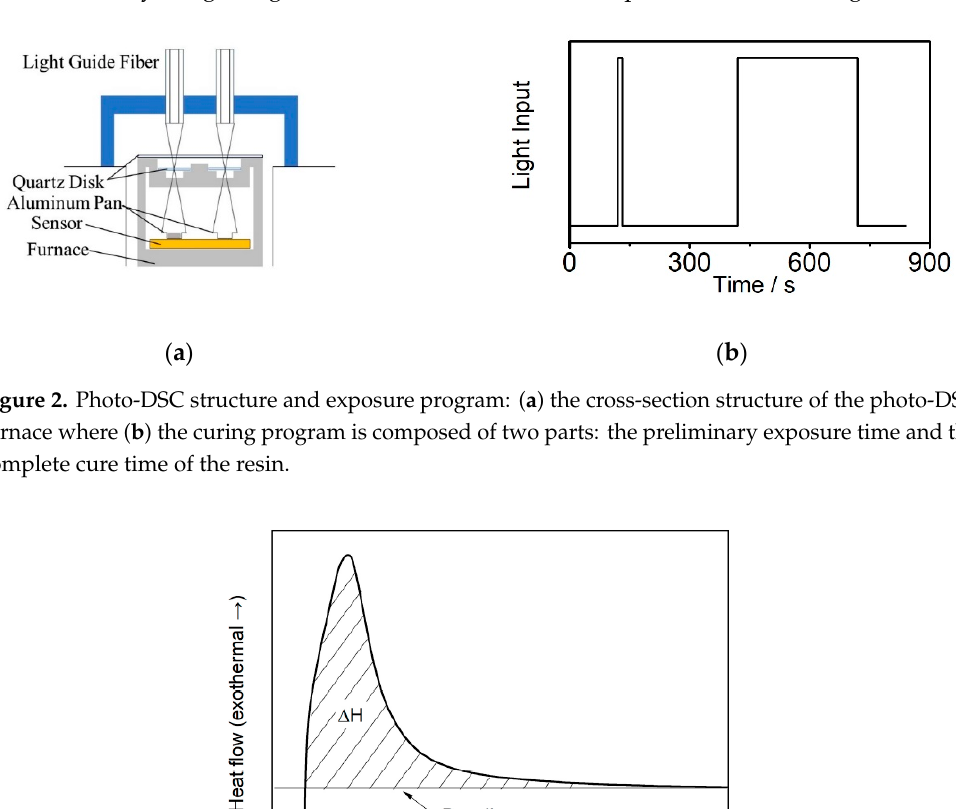
Figure 3. Enthalpy calculation schematic diagram [22].